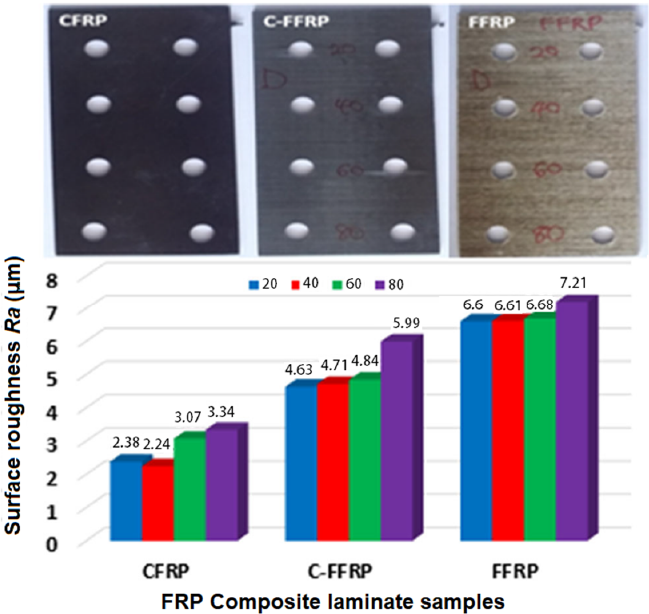
Figure 2. The mean effects of AWJ traverse speed on the surface roughness of sample drilled holes [19]. Image treated to improve quality.